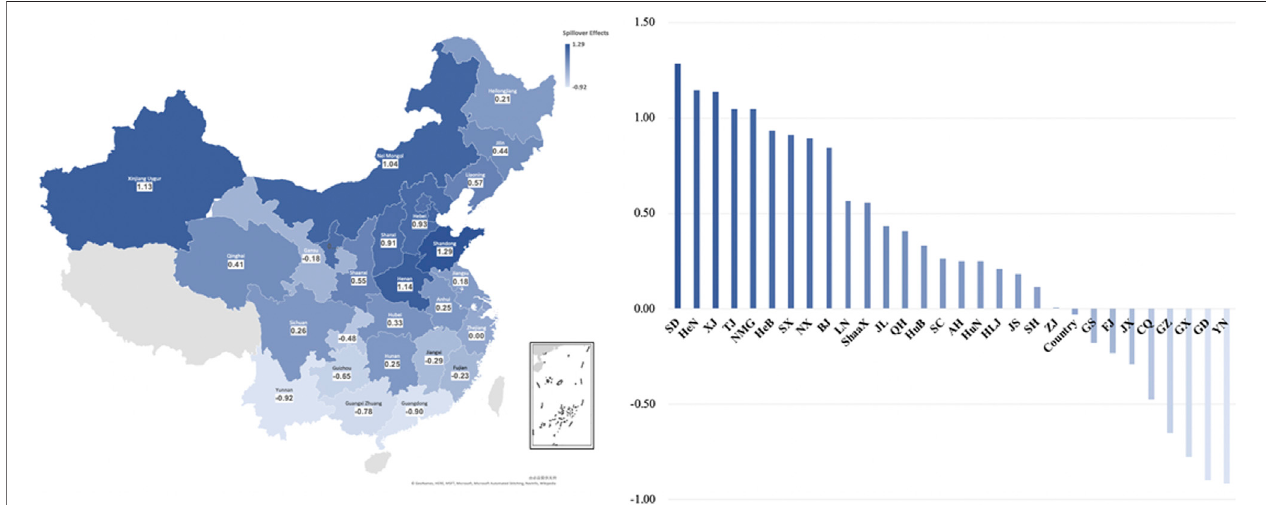
FIGURE 2 | Distribution of spillover effects of spot inspection on technological innovation in each